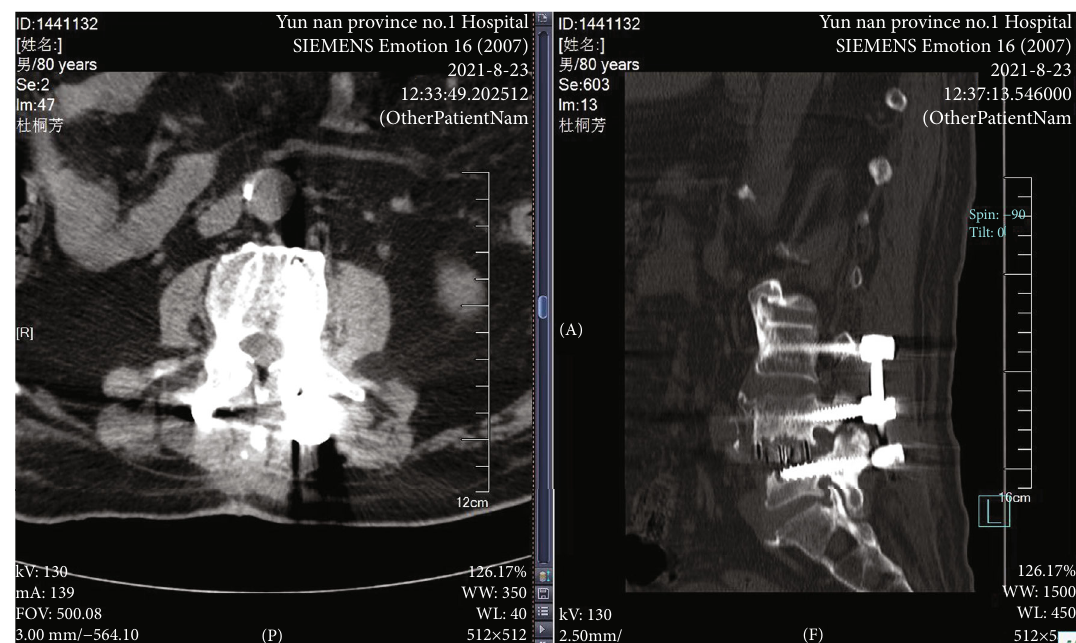
Figure 1: Preoperative CT imaging of the fourth and fi fth lumbar